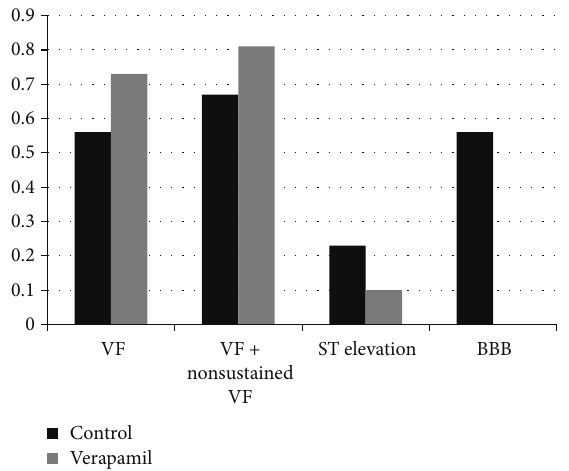
Figure 3: Bar graph of the results of 62 impacts to 12 animals with 36 impacts in 6 control animals and 26 impacts in 6 animals given verapamil. There was no difference in the endpoints of ventricular fibrillation(VF)orthecombinedendpointofVF+nonsustainedVF. Verapamil administration did decrease the severity of ST segment elevation and the induction of a bundle branch block